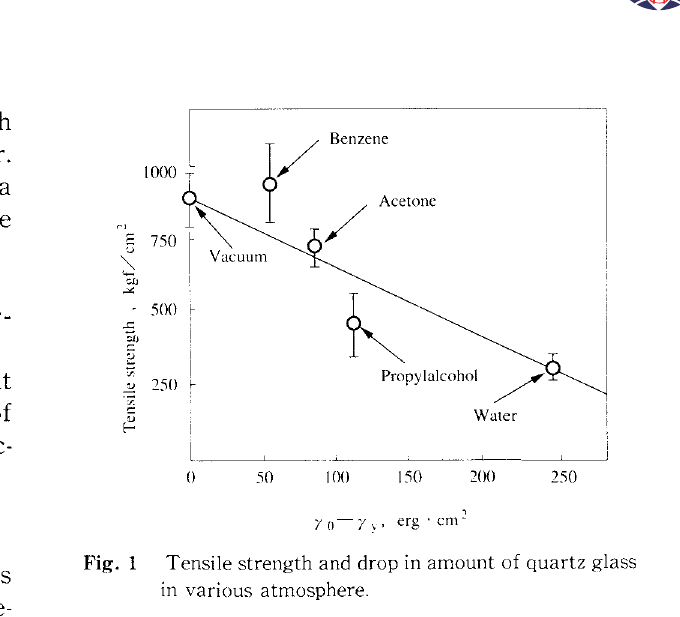
Fig. 1 Tensile strength and drop in amount of quartz glass in various